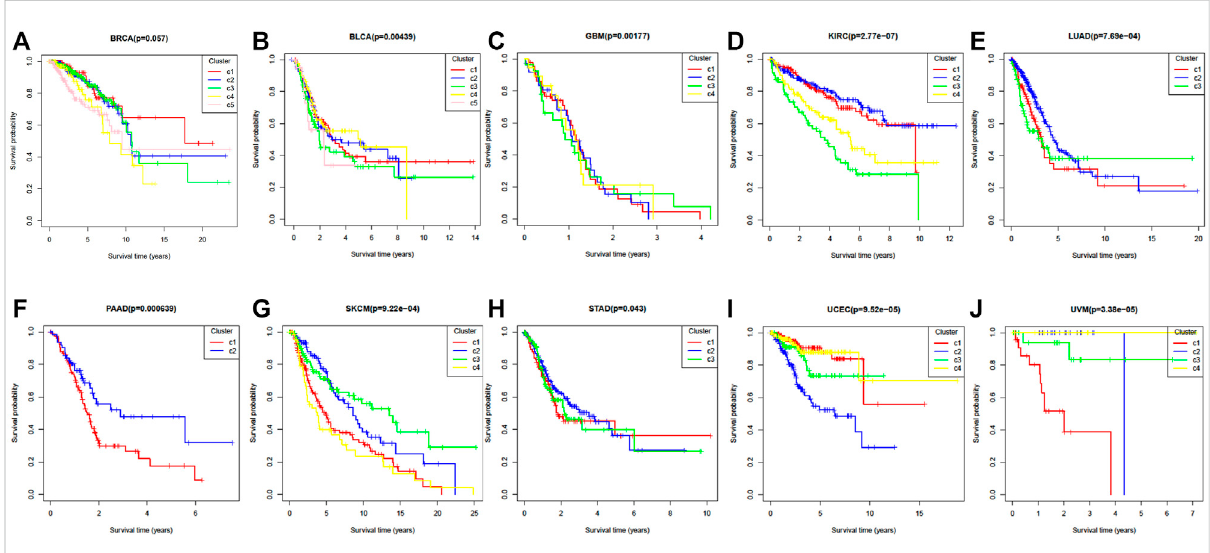
FIGURE 4 The Kaplan – Meier survival curves of ten cancer datasets. (A) BRCA, (B) BLCA, (C) GBM, (D) KIRC, (E) LUAD, (F) PAAD, (G) SKCM, (H) STAD, (I) UCEC, (J)